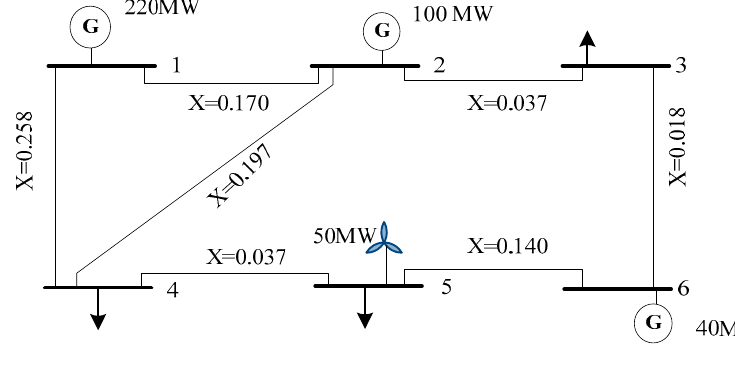
Figure 3. One-line diagram of six-bus system.